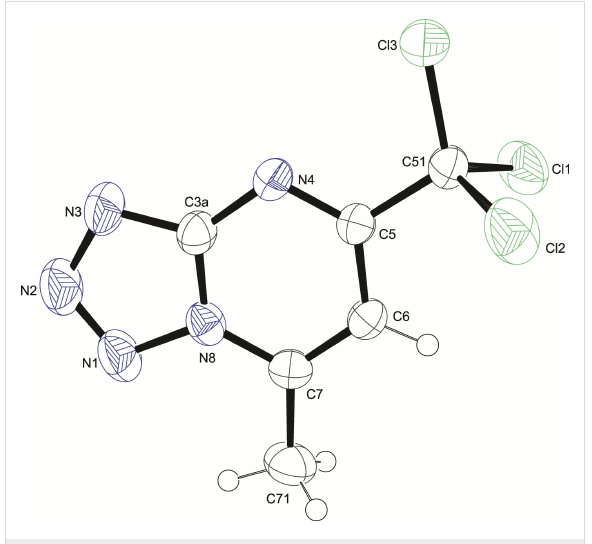
Figure 6: ORTEP ® [45] plot of 8i with thermal ellipsoids drawn at 50% probability level.